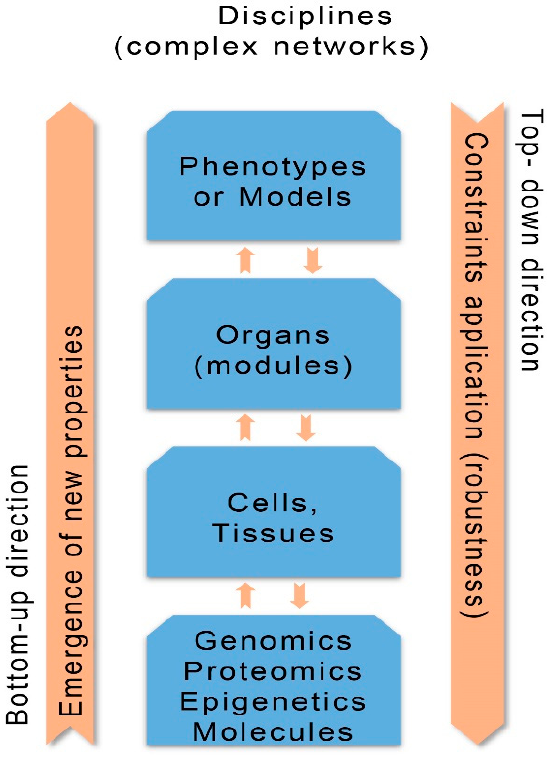
Figure 1. Concepts of systems biology: bottom-up and top-down directions; disciplines (complex networks); emergence of new properties; constraints application (robustness). (Revised from: [5]).